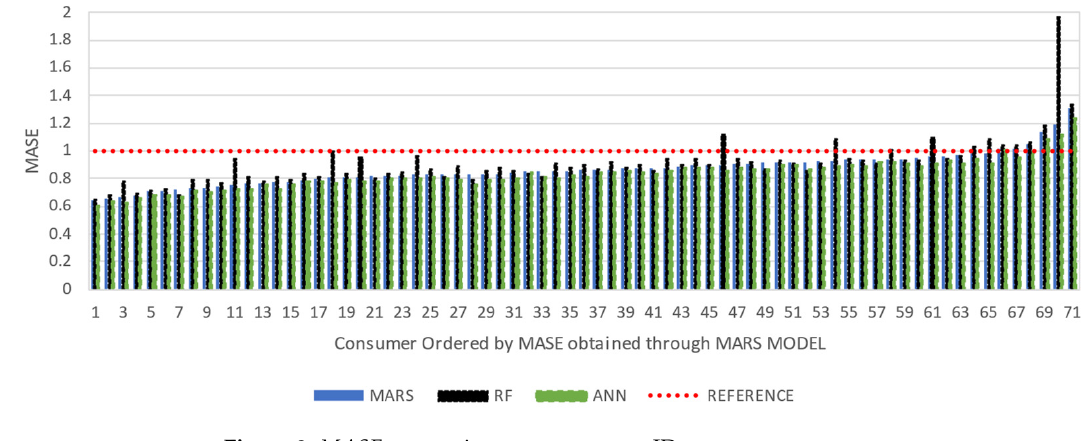
Figure 8. MASE comparison per consumer ID.